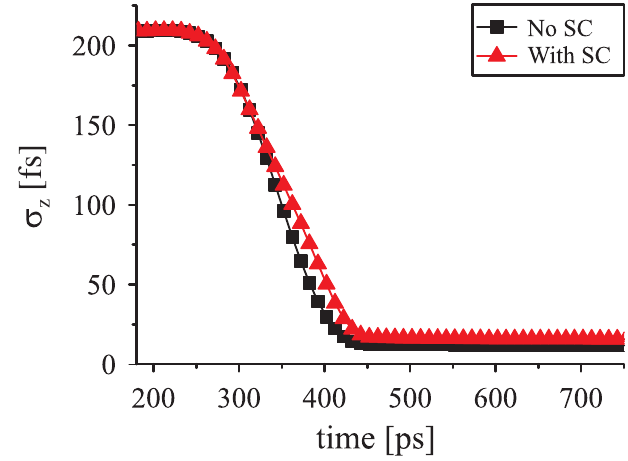
FIG. 12. (Color) Bunch length ( (cid:4) bunch during compression with and without taking space charge into